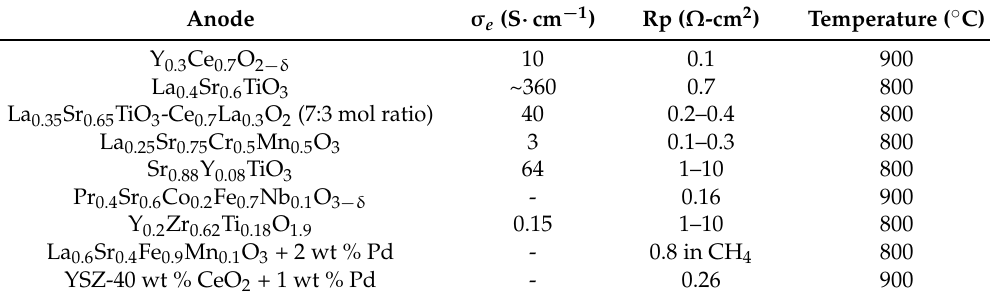
Table 3. Polarization resistance in wet H 2 and electronic conductivity (pO 2 ~ 10 ´ 20 ) for selected anode materials